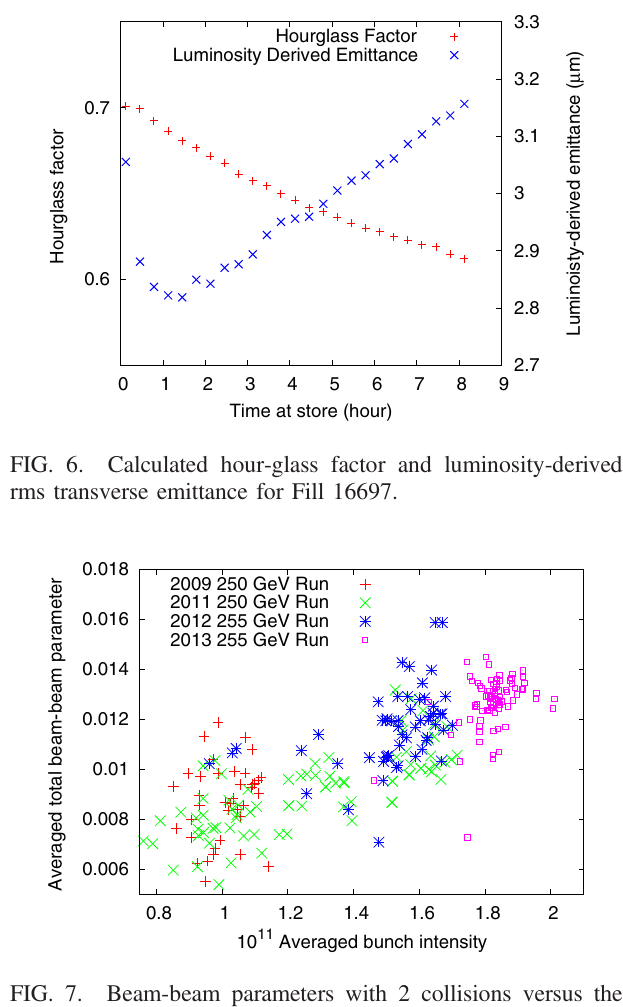
FIG. 7. Beam-beam parameters with 2 collisions versus the average proton bunch intensity in the past 250 = 255 GeV runs.